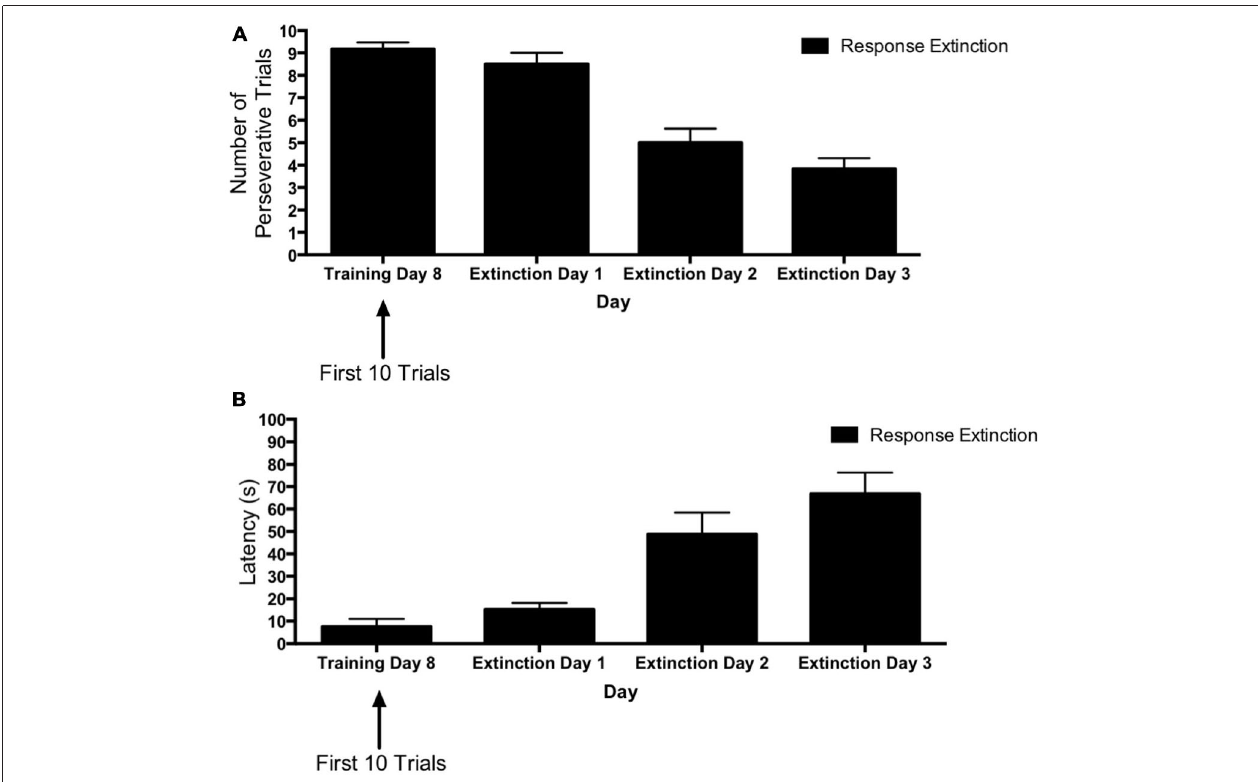
FIGURE 5 | Response extinction of DLS-dependent response learning. (A,B) For animals in the response extinction group, the number of perseverative trials decreased (A) and latency increased (B) indicating the effectiveness of response extinction